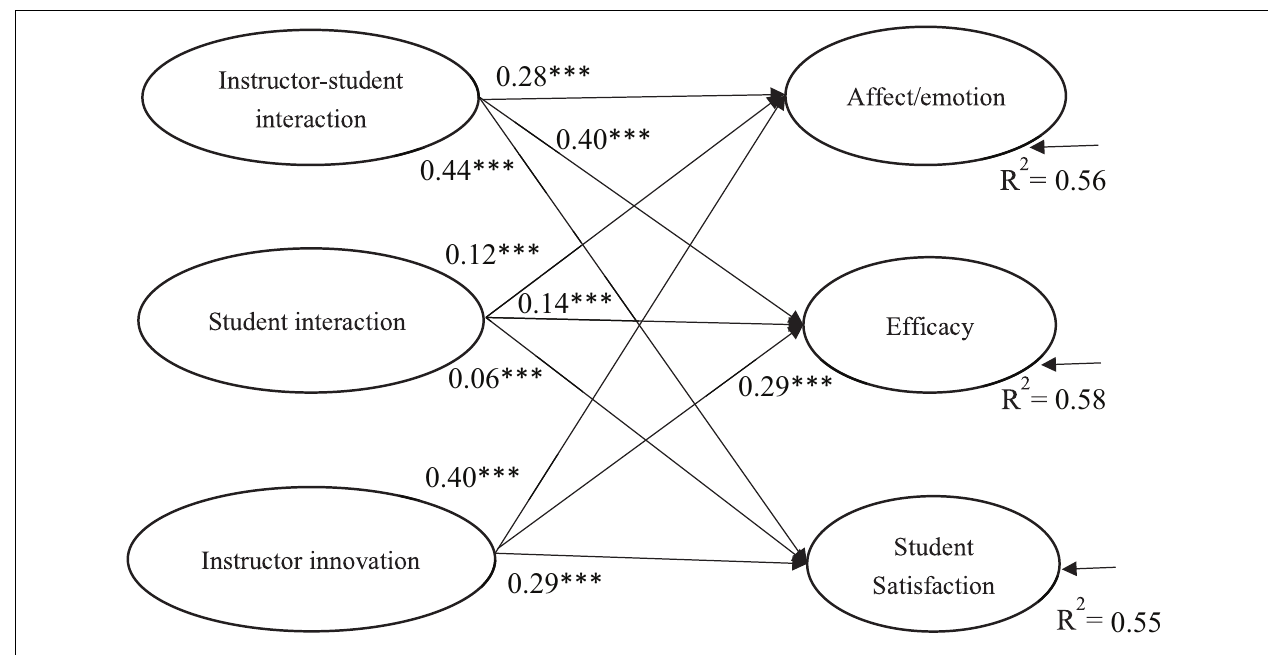
FIGURE 1 | SEM model results showing significant regression paths. ∗∗∗ p < 0.001; Goodness-of-fit indices: χ 2 = 8081.57, df = 262, p < 0.001, CFI = 0.95, TLI = 0.94, RMSEA =